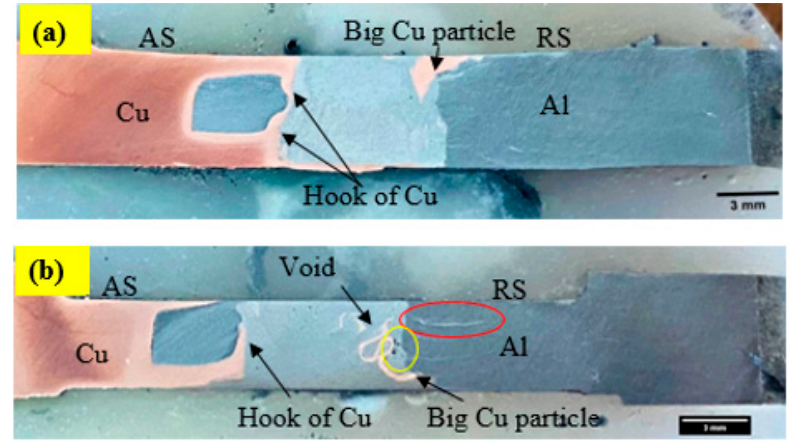
Figure 4. Macrostructure of Al/Cu joint by ( a ) CFSW ( b ) BTFSW.